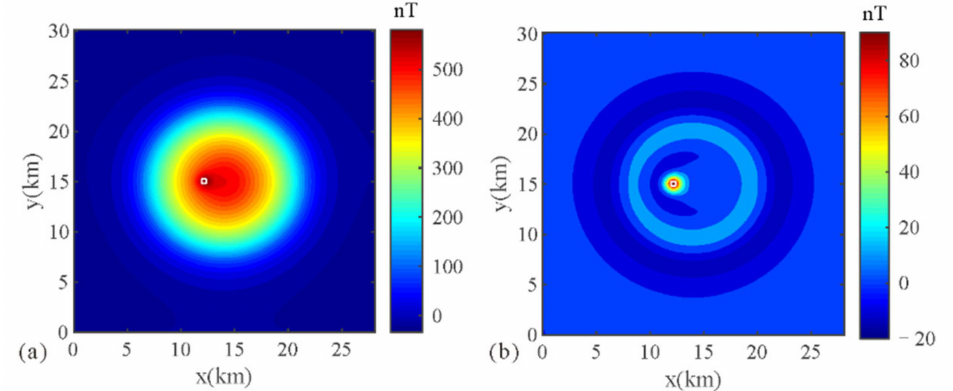
Figure 5. Extraction results of magnetite-caused anomalies based on Figure 4d: ( a ) magnetic reduction-to-pole (RTP) data obtained from Figure 4d; ( b ) magnetite-caused anomalies